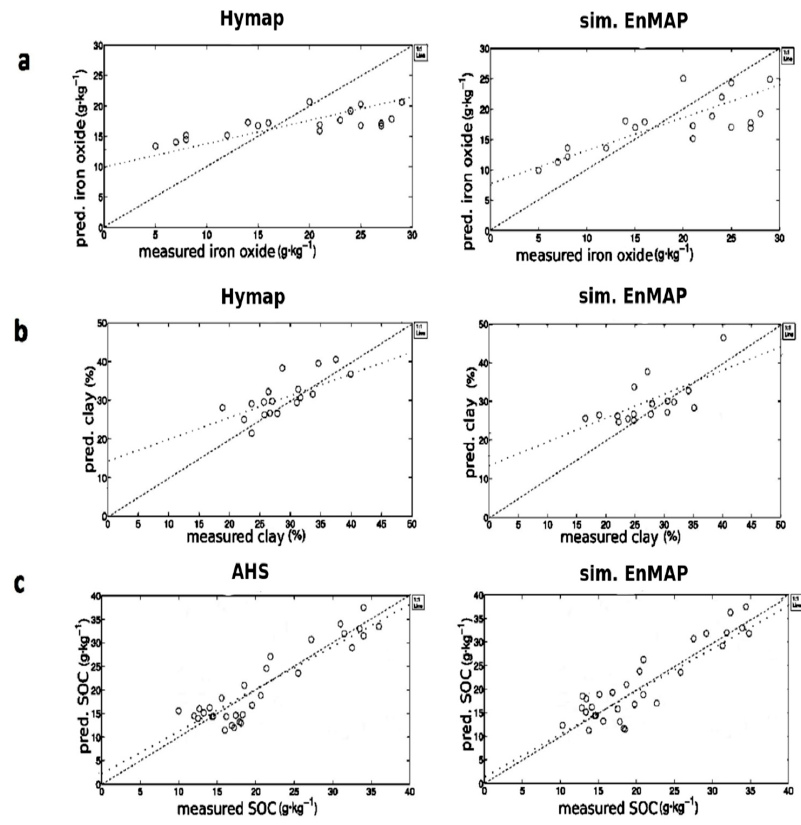
Figure 5. Plots of measured vs. predicted soil parameters for the validation datasets as obtained: ( a ) (cid:1) 1 (cid:4) ( a ) Iron oxide content (g kg ), Cabo de Gata test site; ( b ) Clay content (%), Cabo de Gata test site; Iron oxide content (g·kg − 1 ), Cabo de Gata test site; ( b ) Clay content (%), Cabo de Gata test site; NS ( c ) (cid:1) 1 (cid:4) NS ( c ) SOC content (g kg ), Luxembourg test site. Left : Airborne imagery ( a , b ) HyMAP (4.5 m) and SOC content (g·kg − 1 ), Luxembourg test site. Left : Airborne imagery ( a , b ) HyMAP (4.5 m) and ( c ) AHS (2.6 m); Right : Spaceborne simulated EnMAP images (30 m). ( c ) AHS (2.6 m); Right : Spaceborne simulated EnMAP images (30 m). RPIQ varies from ~1.4 (clay %, EnMAP) to ~2.9 (SOC g·kg − 1 , AHS). With the exception of the (cid:1) 1 RPIQ varies from ~1.4 (clay %, EnMAP) to ~2.9 (SOC g (cid:4) kg , AHS). With the exception